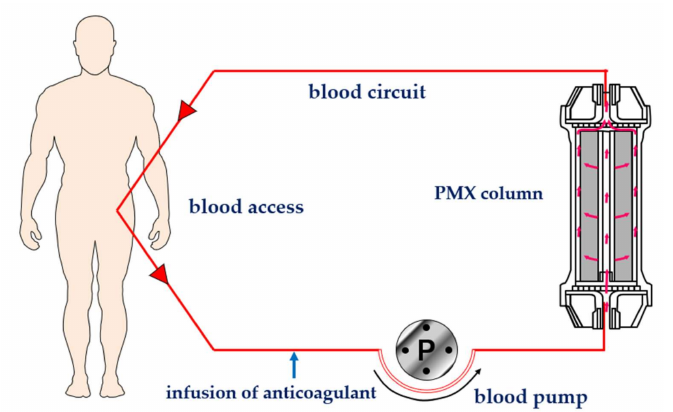
Figure 2. Schematic diagram of hemoperfusion with PMX (PMX-HP). PMX: polymyxin B immobi- lized fiber